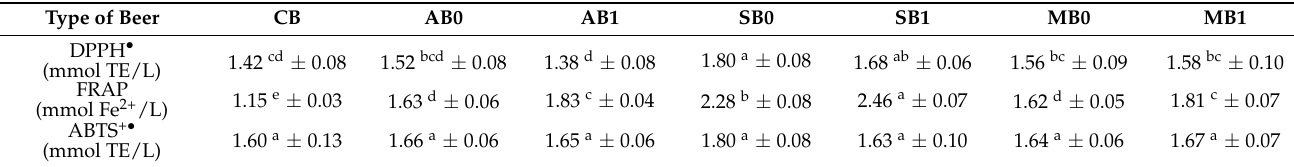
Table 5. Antioxidant potential of fruit beers with Saskatoon fruit pulp added.